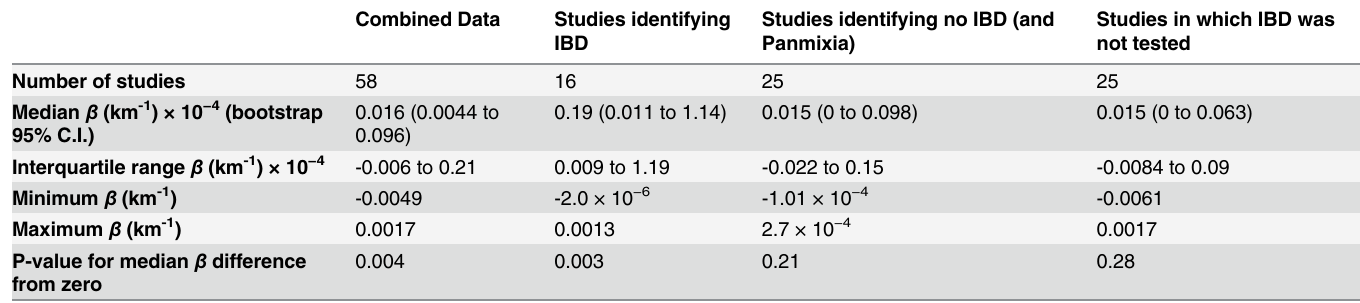
Table 2. Rates of F ST over geographic distance ( β ) collected in the meta-analysis of marine fish. For the combined data set, the number of studies equals the number of species (slopes averaged across studies; see Materials and methods). Combined Data Studies identifying Studies identifying no IBD (and Studies in which IBD was IBD Panmixia) not